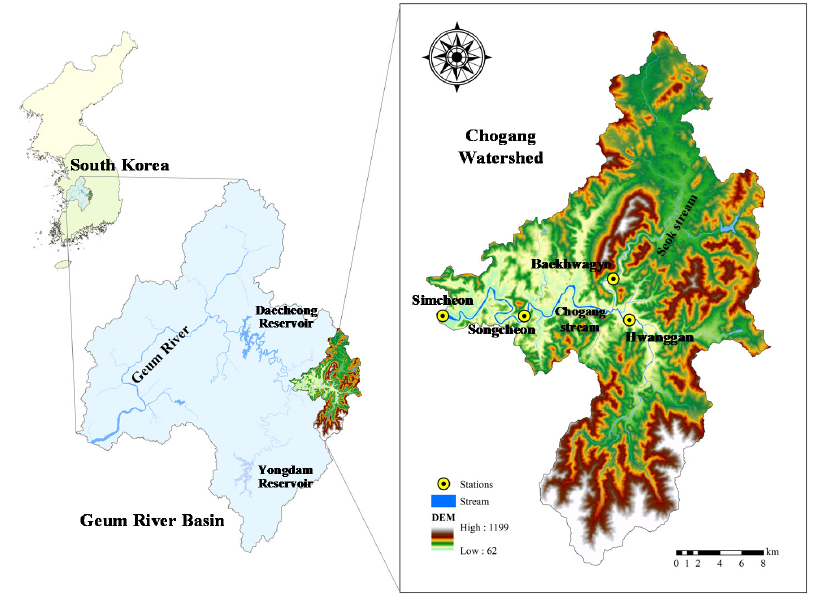
Figure 1. Study area and streamflow gauging stations.